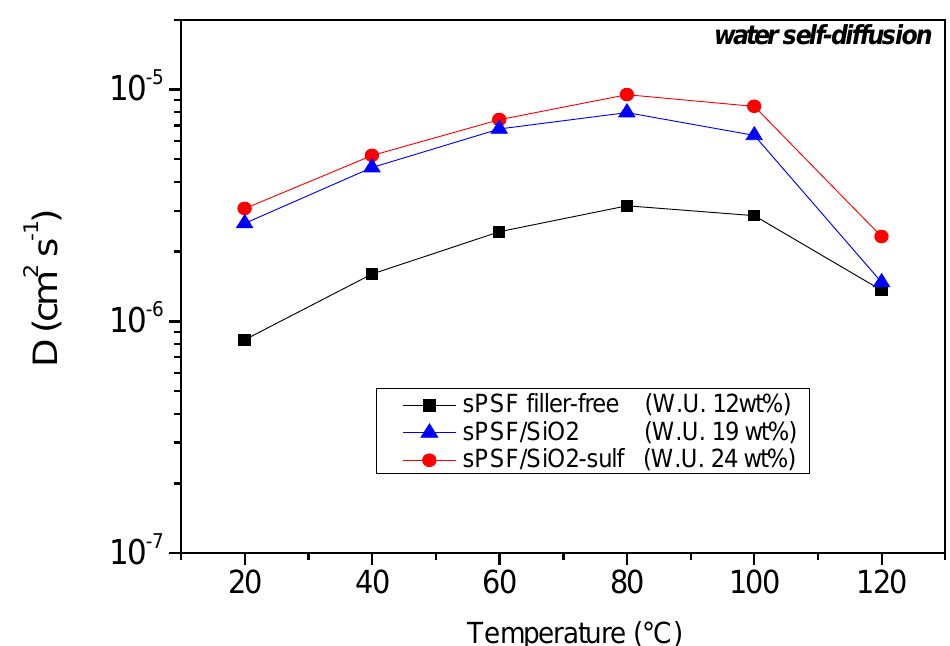
Figure 2. Water self-diffusion coefficients as a function of temperature for the different polysulfone membranes.